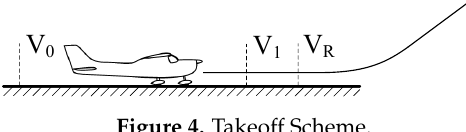
Figure 4. Takeoff Scheme.